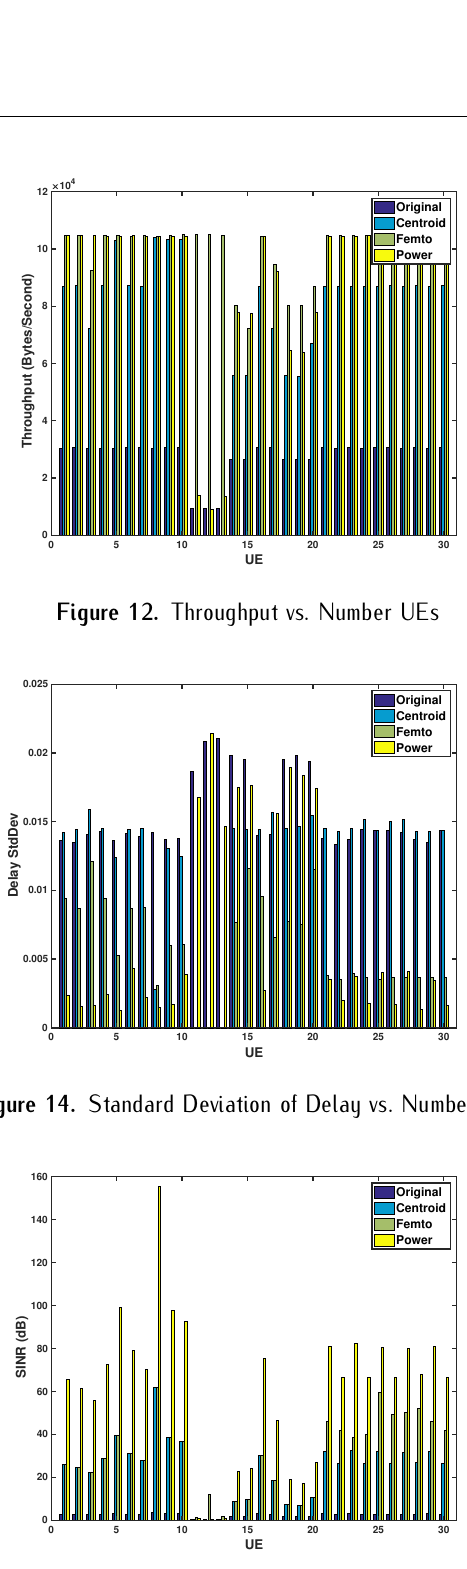
Figure 15. Packet Loss Ratio vs. Number UEs Figure 16. SINR vs. Number